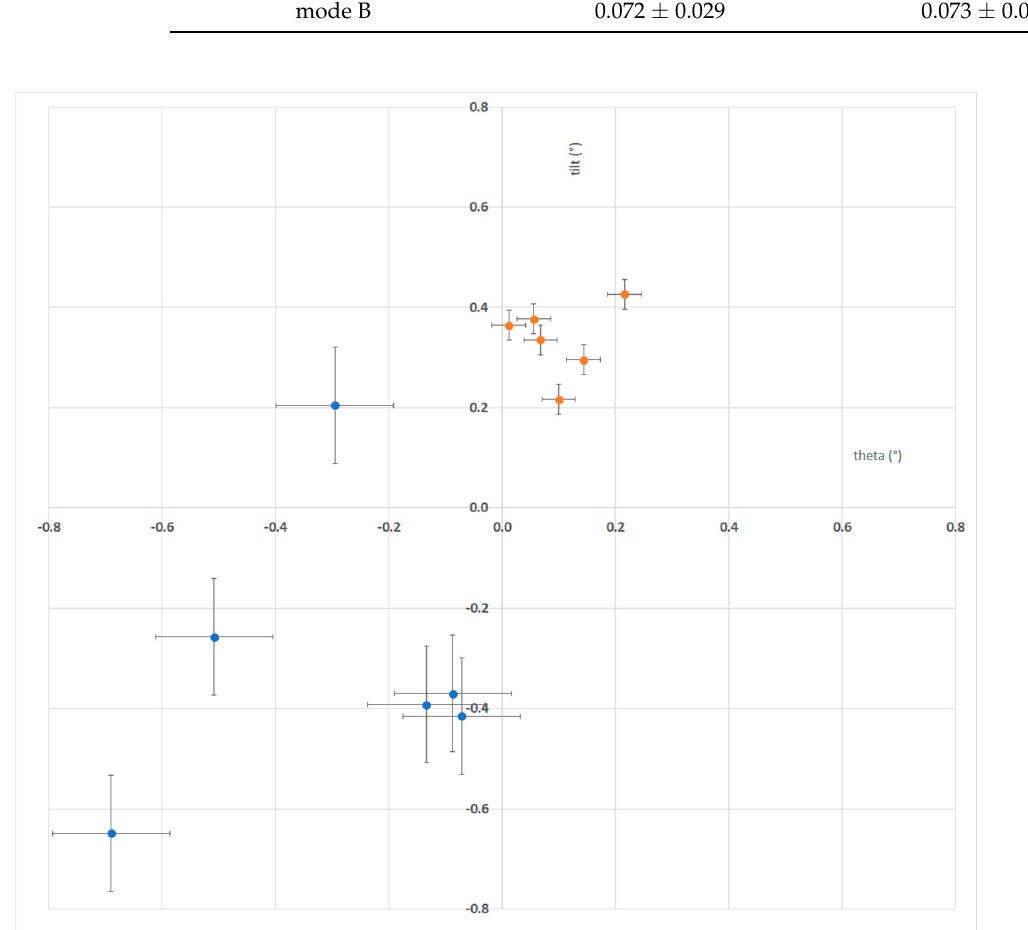
Figure 18. Points of intersections of planar axes measured by both mode A (blue points) and B (red points). Table 3. Centroid and dispersion of planes intersections.